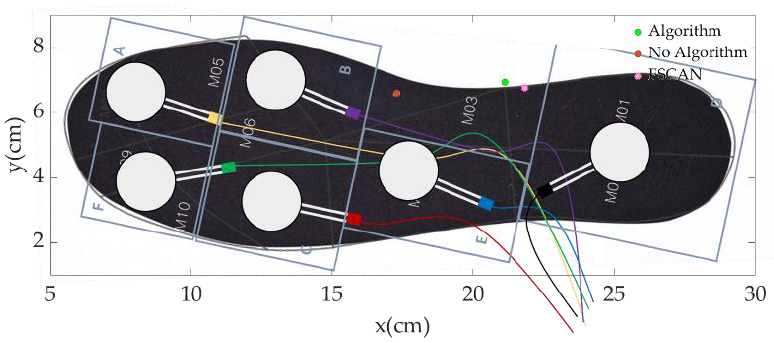
Figure 9. One chosen frame of CoP trajectory plot during the scan experiment by WMA (No Algorithm) with orange point, the VFA (Algorithm) with green point, and the reference data (F-Scan) with pink point. Table 3. Numerical values of frame in Figure 9.